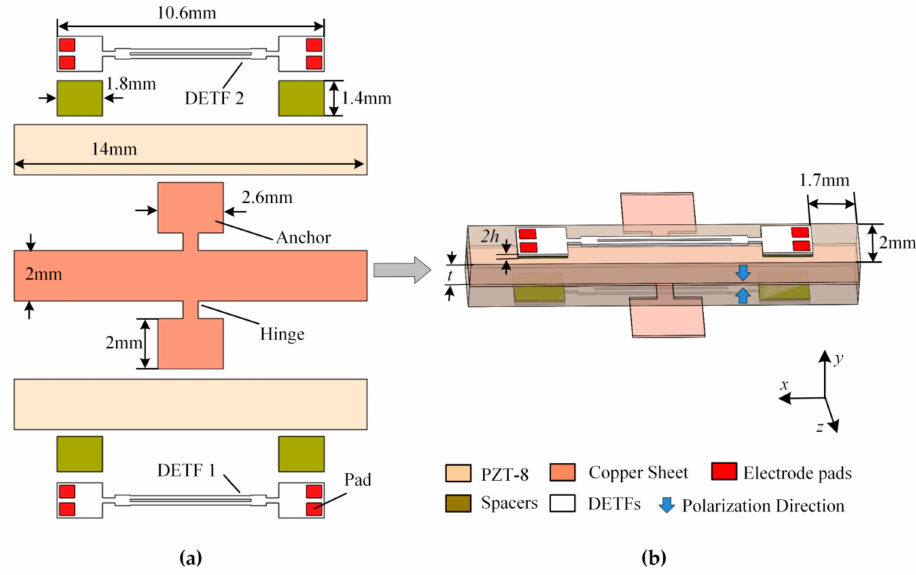
Figure 1. Schematic diagram of the di ff erential resonant voltage sensor. ( a ) The components of the sensor; ( b ) the assembled